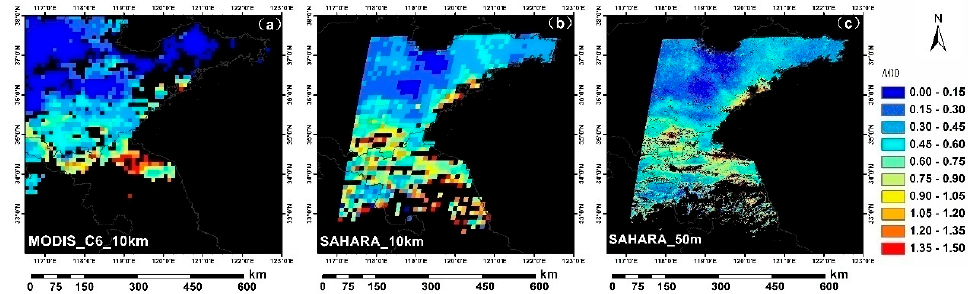
Figure 10. The comparison between SAHARA AOD using GF4 data and MODIS C6 combined AOD on 25 June 2016: ( a ) MODIS C6 combined AOD; ( b ) SAHARA 10 km AOD; ( c ) SAHARA 50 m AOD. Remote Sens. 2017 , 9 , 253 16 of 22